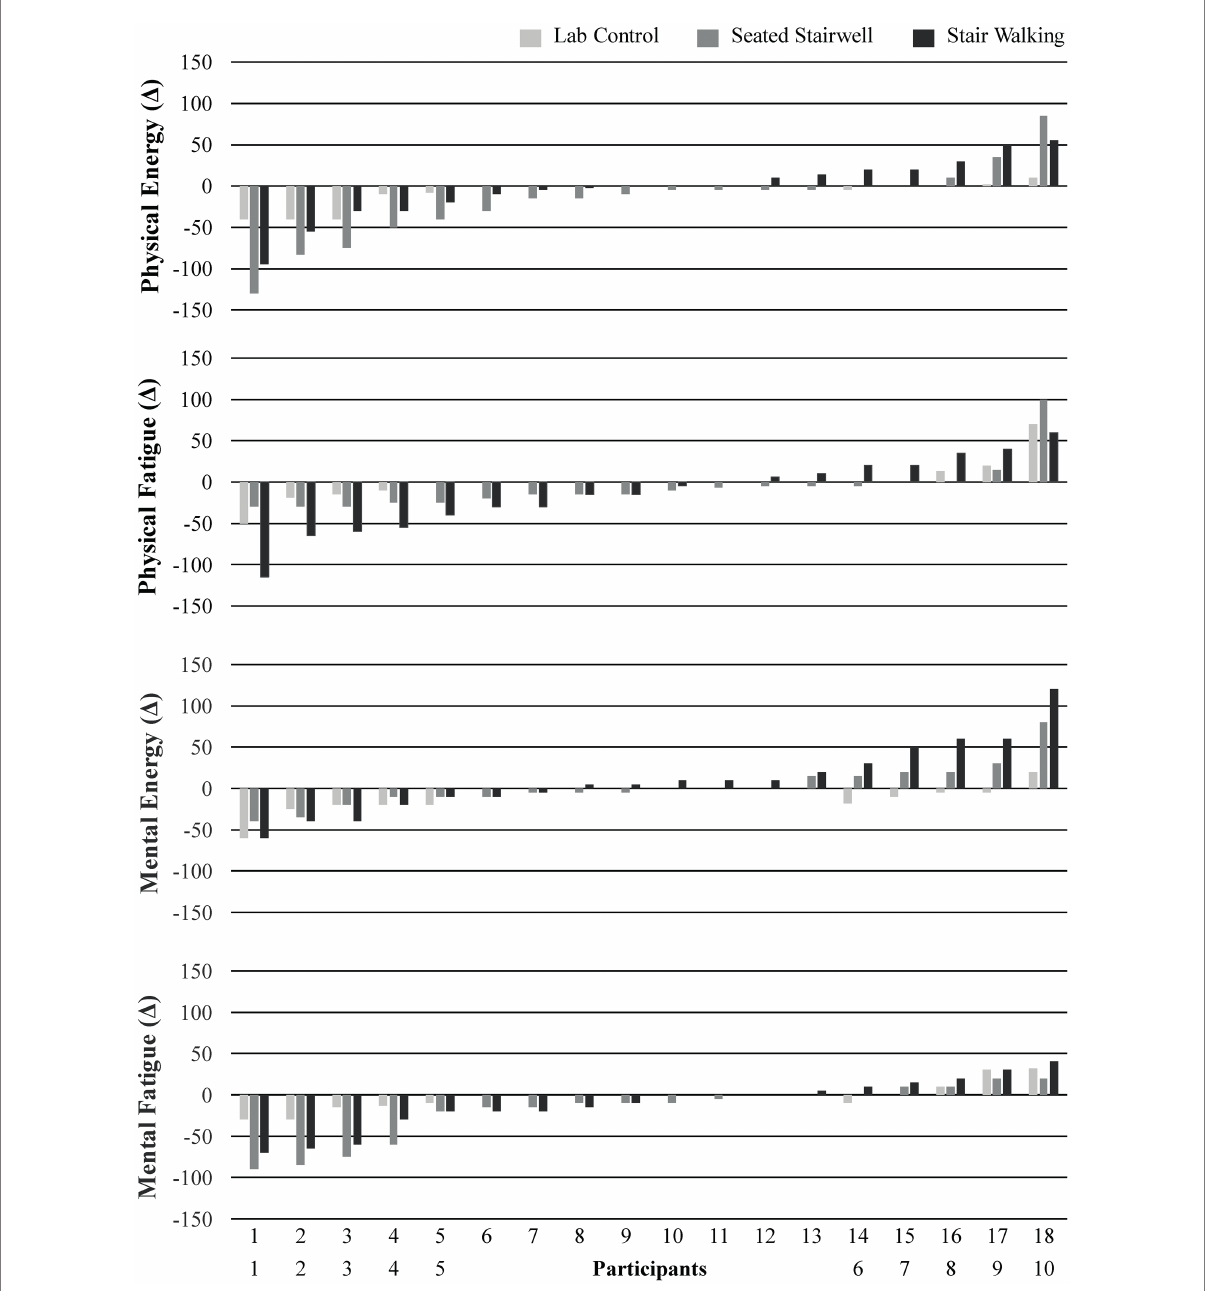
FIGURE 2 Individual changes in physical energy, physical fatigue, mental energy, and mental fatigue before and after the experimental protocol. The range of possible change is ±300. Due to the uneven group sizes, the seated laboratory control group ( n = 10) scores are presented as the first 5 and last 5 values of the seated stairwell and stair walking groups ( n =